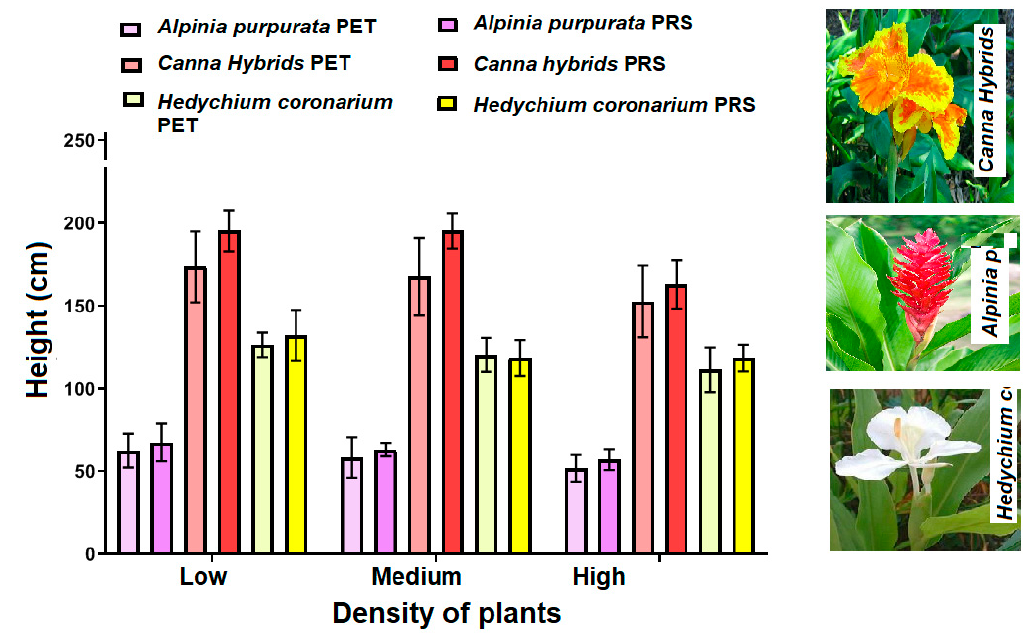
Figure 2. Average maximum height of the vegetation under study in the three different plant densities (under PET and PRS substrates).